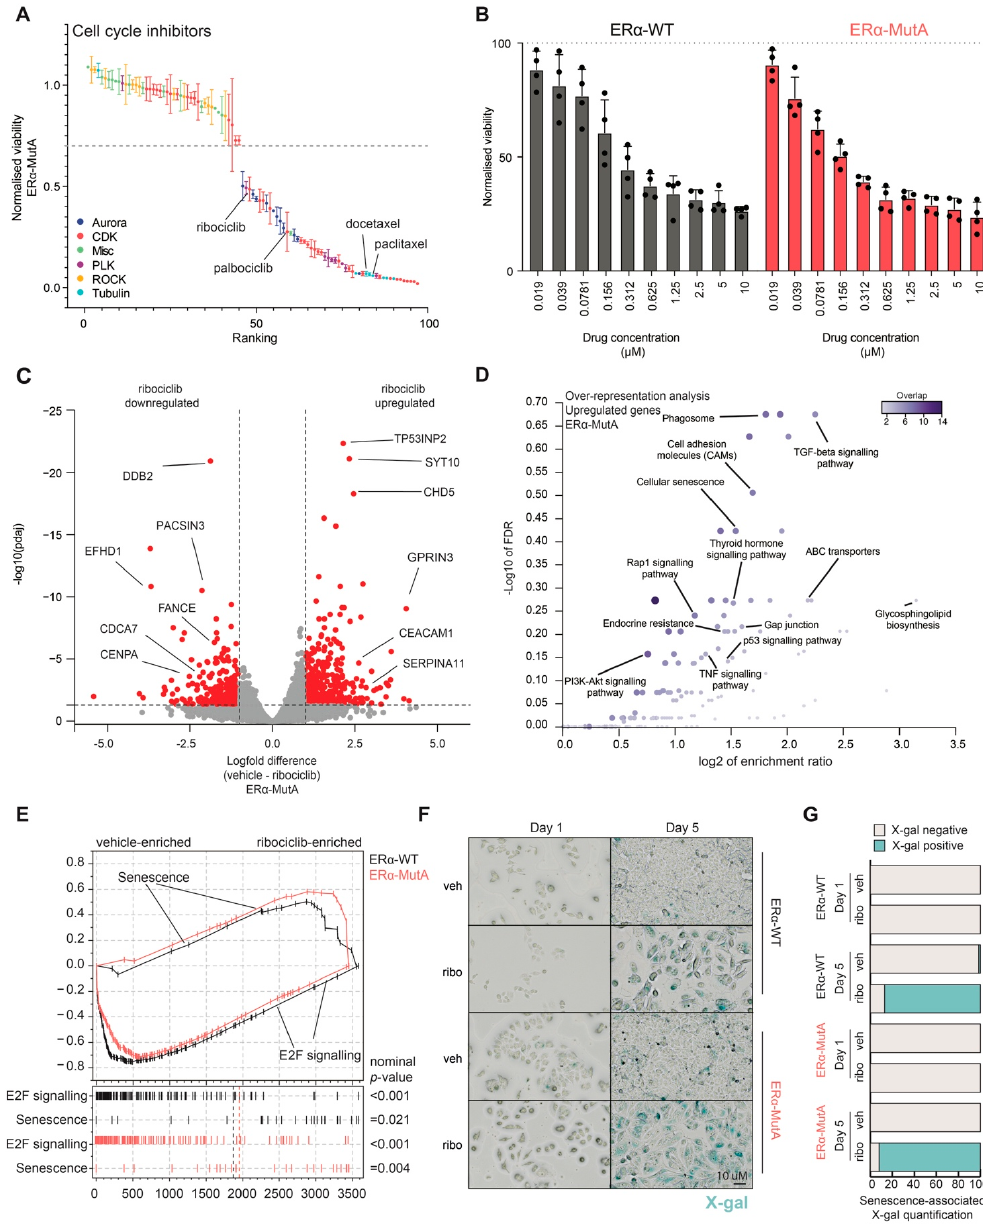
Figure 2. CDK4/6 inhibitors induce senescence in cells harbouring mutant ER α . ( A ) Compounds belonging to the cell cycle category (dark blue, aurora; red, CDK; green, misc.; purple, PLK; orange, ROCK; light blue, tubulin) were annotated based on their target and ranked according to their effect on E α R-MutA viability. Mean ±SD are depicted ( n = 3). ( B ) ER α -MutA and ER α -WT cells were cultured with CDK4/6 inhibitor ribociclib. After six days, cell viability was measured using CellTiter-Glo. Bars depict mean value ±SD ( n = 4). ( C ) Volcano plot depicting log2fold differences from an RNA sequencing experiment of ER α -MutA cells treated with either Vehicle or 600 nM ribociclib for five days ( n = 2). Differentially expressed genes (log2fold < − 1 and >1; p-adj = 0.05) are shown in red. Adjusted p -values (padj) were determined by DESeq2 (Wald test p -values corrected for multiple testing using Benjamini and Hochberg method). ( D ) Over-representation analysis of genes upregulated by ribociclib treatment in ER α -MutA cells ( n = 2). FDR was computed using WebGestalt tool. ( E ) Gene-set enrichment profile of whole-proteome data for E2F signalling and senescence gene-set for ER α -MutA and ER α -WT cell lines ( n = 4). Nominal p -values were determined by GSEA software. ( F ) Representative images of senescence- associated β -galactosidase (X-gal) stained cells, untreated (veh), or ribociclib treated (ribo) ( n = 3). Scale bar, 10 µ m. ( G ) Quantification of at least 200 cells from senescence-associated β -galactosidase experiments represented in fraction of negative (grey) and positive cells (blue) ( n =